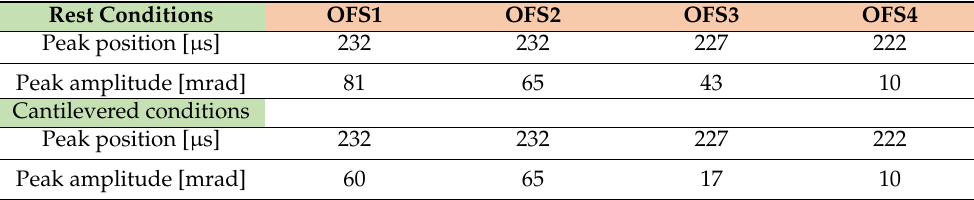
Table 4. Main parameters of the Lamb wave detected by the φ -OTDR